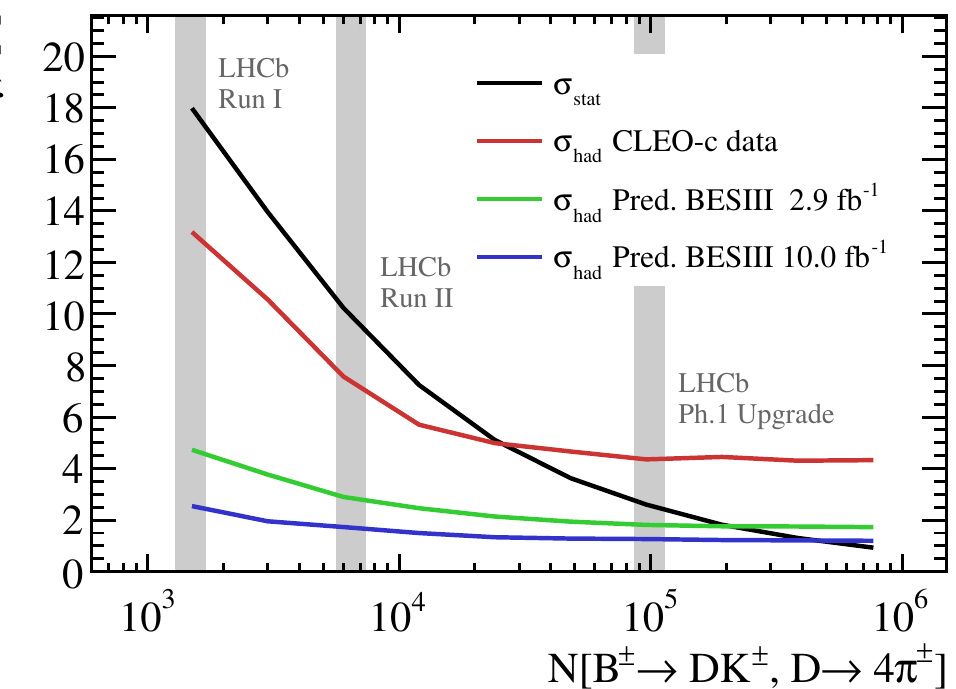
Figure 13 . Expected (cid:13) uncertainties obtained using di(cid:11)erent numbers of B (cid:6) ! DK (cid:6) ; D ! 4 (cid:25) (cid:6) decays and the default binning scheme. The black line shows the estimated uncertainty due to limited B (cid:6) ! DK (cid:6) ; D ! 4 (cid:25) (cid:6) statistics. The red, green and blue lines shows the estimated uncertainty due to the measured/predicted constraints on the 4 (cid:25) (cid:6) hadronic parameters from CLEO- c data with 0.818 fb (cid:0) 1 , BES III with 2.9 fb (cid:0) 1 , and BES III with 10.0 fb (cid:0) 1 , respectively. The